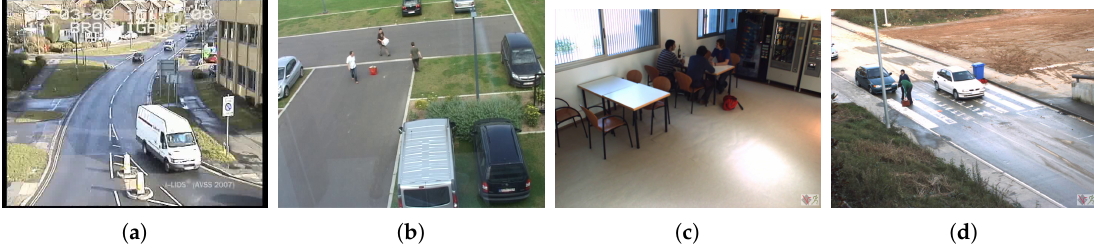
Figure 17. Sample frames from the ( a ) AVSS 2007 PV, ( b ) CANTATA C2, ( c ) HERMES Indoor, and ( d ) HERMES Outdoor